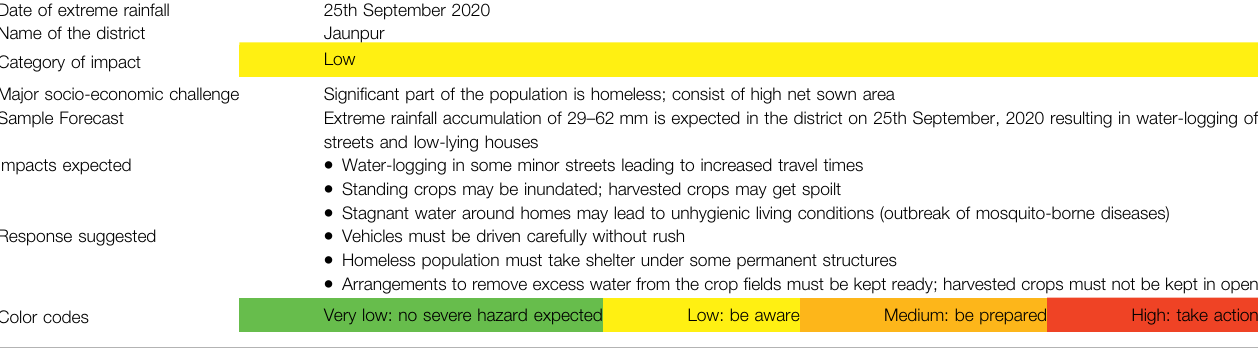
TABLE 5 | A sample IBF generated for the district Jaunpur.